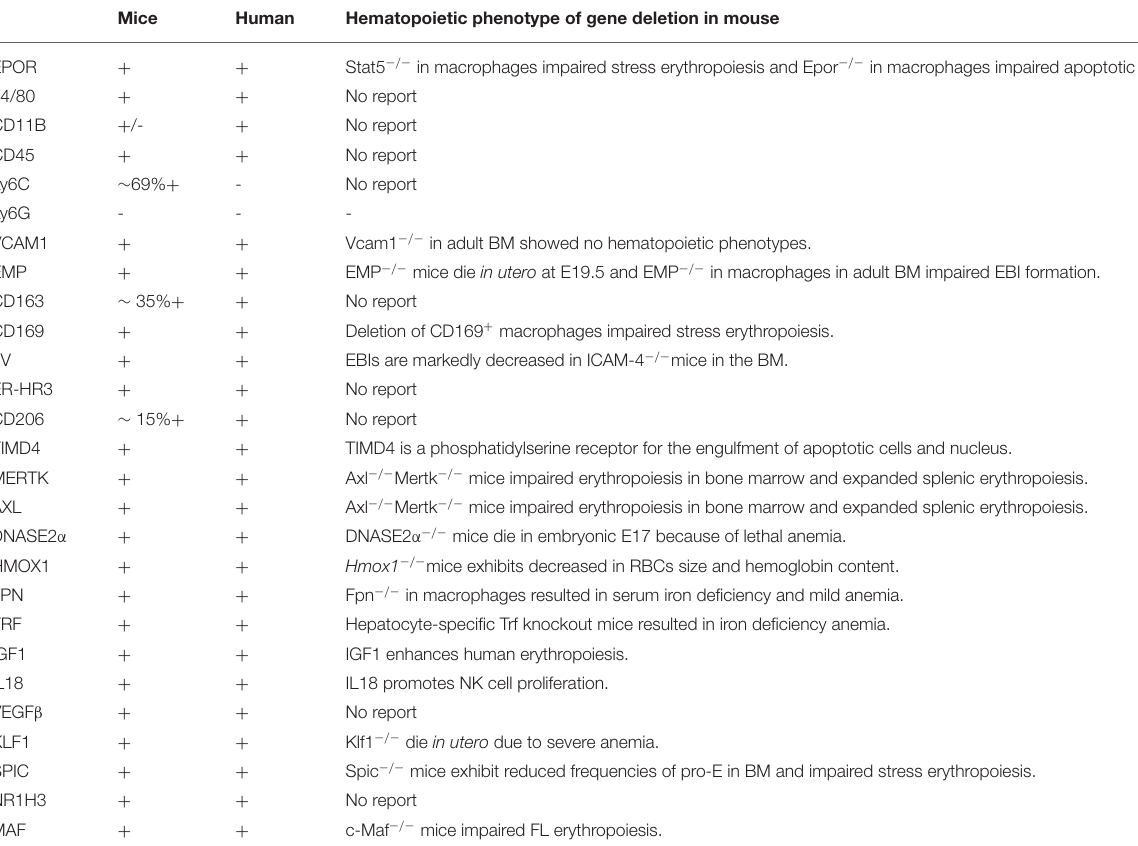
TABLE 1 | List of markers of EBI macrophages in mice and human and potential hematopoietic phenotype of gene deletion mice models. Mice Human Hematopoietic phenotype of gene deletion in